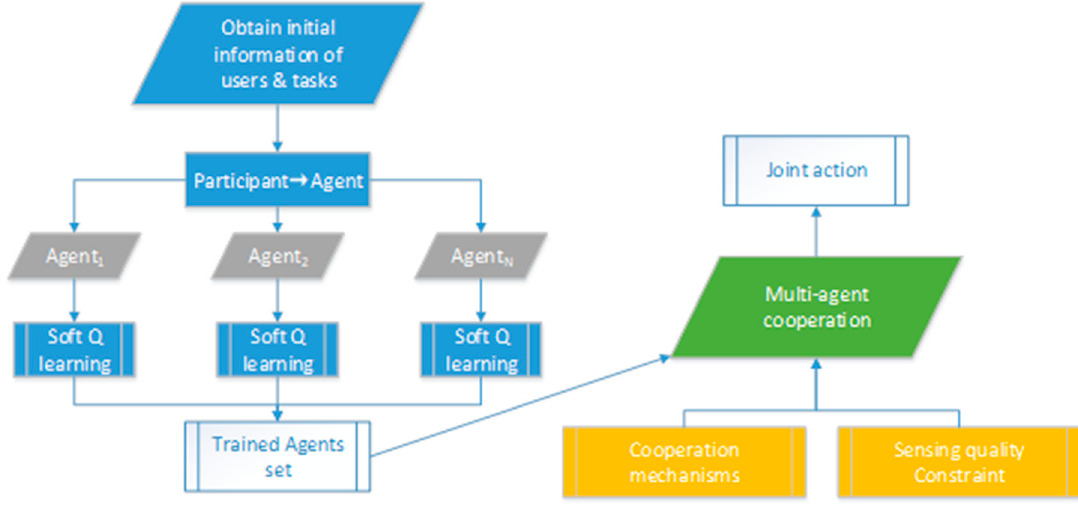
Figure 2. Multi-agent reinforcement learning framework.